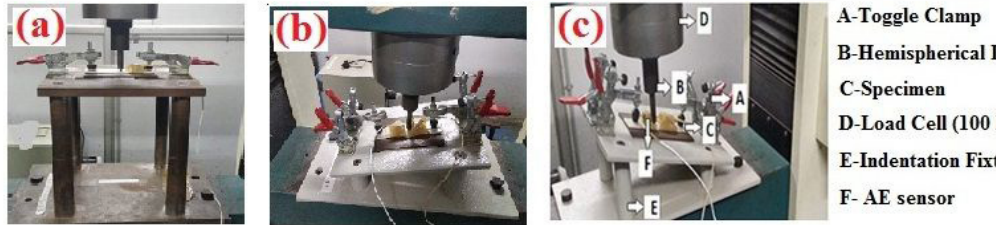
Figure 1. QSI test fixture for different loading planes (a) 0 o , (b) 10 o and (c) 20 o